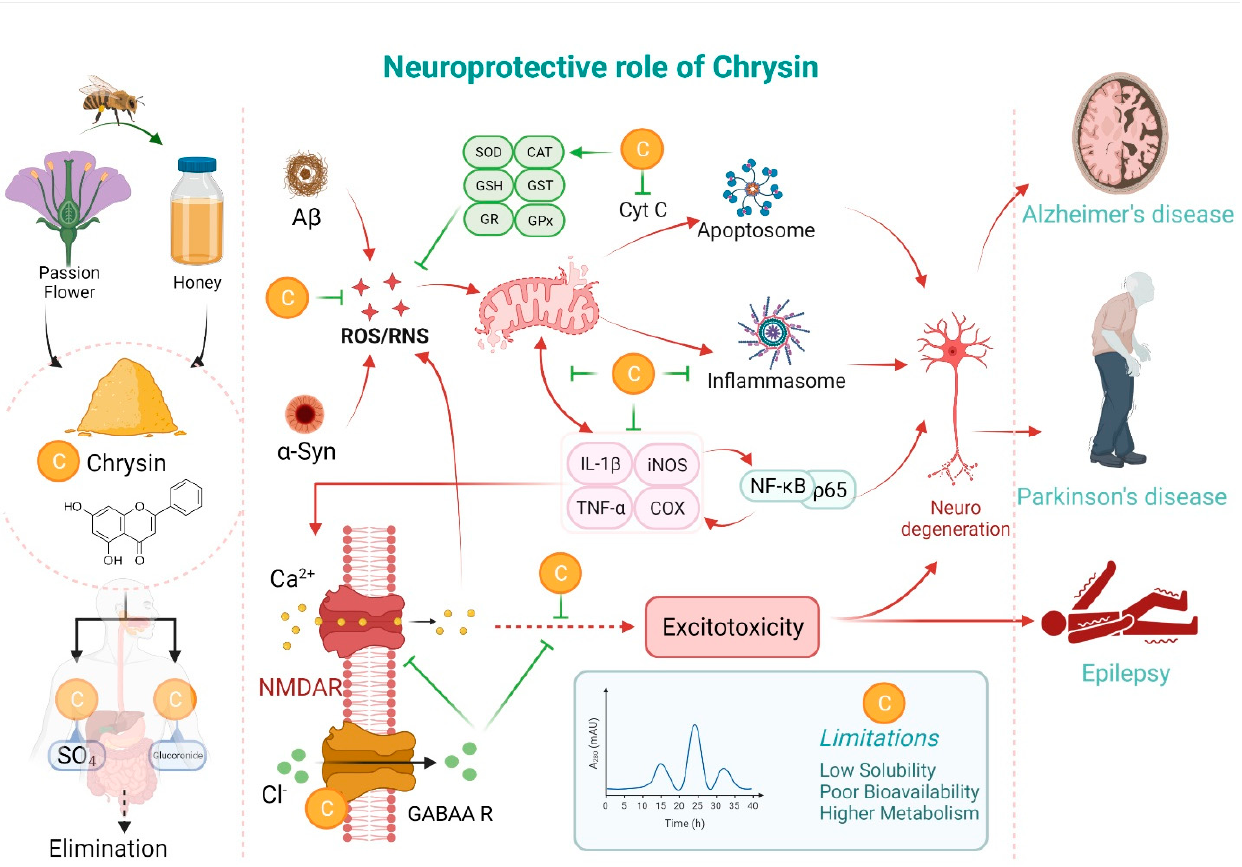
Figure 2. Effects of chrysin in the signaling networks associated with multiple neuropathological conditions.